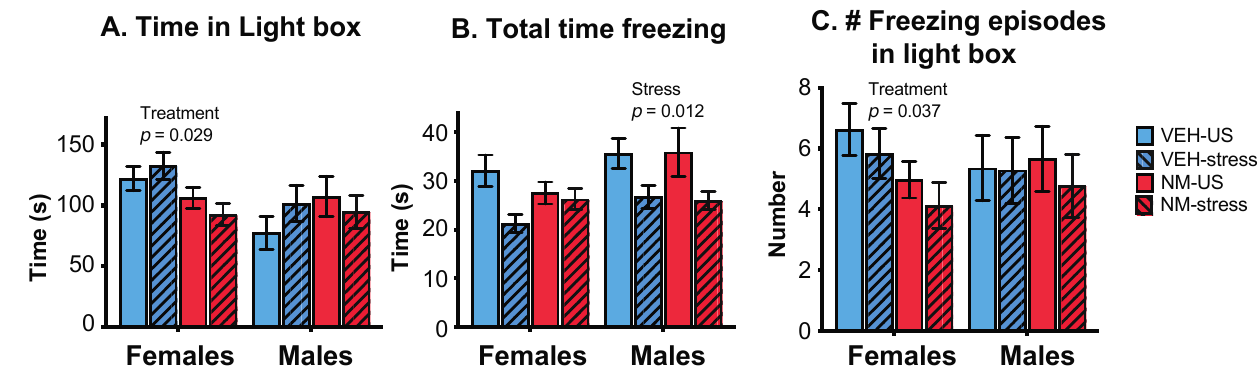
Figure 3. Effects of prenatal NeuroMix and/or stress in adolescence on behaviors in the light:dark box. ( A ) Time spent in the light box was significantly decreased in NeuroMix compared to vehicle in females. ( B ) Total time freezing was decreased by adolescent stress in males, and there was also a trend for a decrease in stress in females ( p = 0.066). ( C ) The number of freezing episodes in the light box was significantly decreased by treatment in females and unaffected in males. Sample sizes for vehicle–US, vehicle–stress, NeuroMix–US, and NeuroMix–stressed females: n = 27, 19, 30 and 22; for males, n = 28, 21, 30, and 22. VEH = Vehicle; NM = NeuroMix; US = unstressed. Males: There were no main effects of treatment on the behavior of males in the LD box, but there were main effects of stress. Males that experienced stress during